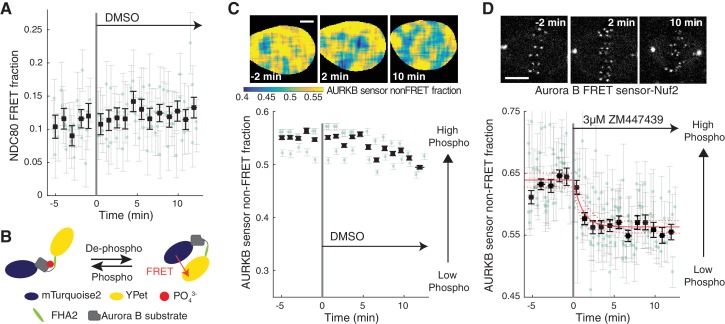
Supplemental data for Aurora B inhibition experiments.(A) Time course of NDC80 FRET fraction in response to 0.03% DMSO (n = 5 cells, negative control for Figure 4A). (B) The design of Aurora B FRET biosensor. The FRET sensor contains a kinesin-13 family Aurora B substrate (gray) whose phosphorylation results in its binding to the forkhead-associated domain (FHA2, green) in the sensor, which constrains the sensor in the open non-FRET state. Therefore, measuring the non-FRET fraction of the FRET sensor allows the quantification of Aurora B activity. (C) Time course of the non-FRET fraction of cytoplasmic Aurora B FRET sensor in response to 0.03% DMSO (n = 3 cells, negative control for Figure 4E). (D) Time course of the non-FRET fraction of Nuf2-targeted Aurora B FRET sensor in response to 3 μM ZM447439 (n = 9 cells). Black squares and error bars are the weighted mean and SEM of the data points (green circles) in equally spaced time intervals of 1 min. Red solid and dashed lines are the best-fit exponential model and its 95% confidence interval, respectively. 5 μm scale bars.